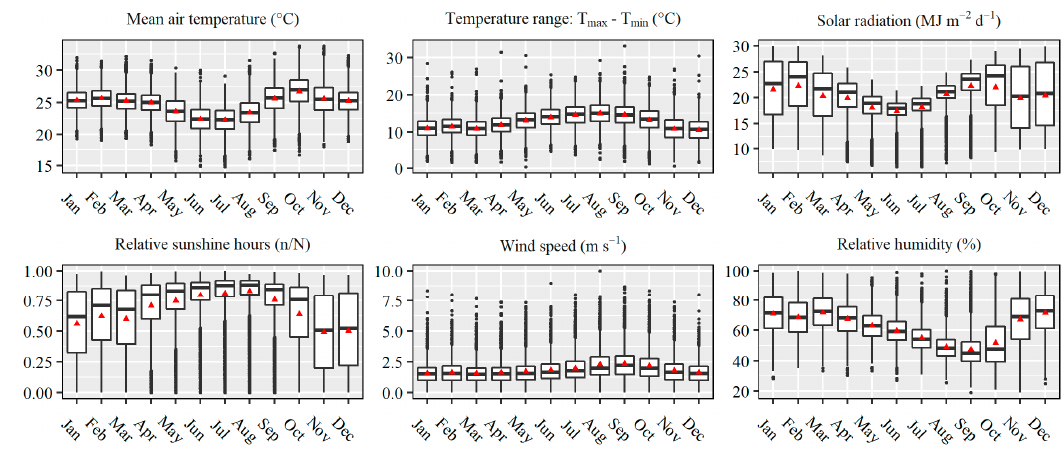
Figure 2. Descriptive statistics of meteorological parameters for the middle São Francisco from 1997 to 2016.